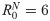
The dependence of R0 on the vaccine-induced sterilizing immunity, ϵs, vaccine-induced reduction in host infectivity, ϵi, vaccine-induced increase in recovery rate, ϵγ, and vaccine coverage, p.A. 3D surface plot corresponding to R0 = 1 in Eq (12), for a high average transmission potential (R0N=6) and full immunization coverage (p = 1). B. 2D contour plot showing the dependence of R0 on ϵi and ϵγ, for different values of ϵs and p = 1. C. 3D surface plot corresponding to R0 = 1 in Eq (12), for a high average transmission potential (R0N=6) and ϵi = 0.5. D. 2D contour plot showing the dependence of R0 on the effective vaccine coverage, p, and ϵγ, for different values of ϵs and ϵi = 0.5. The coloured continuous curves in 2D plots correspond to R0 = 1 in Eq (12) for a high average transmission potential (R0N=6) and dotted curves correspond to R0 = 1 for a low virulent PRRSv strain (R0N=2). Areas above these curves correspond to R0 < 1 where the infection cannot invade the herd. Here d = 0.001, μ = 0.0017. The transmission and recovery rates are values within the ranges given in Table 2, that satisfy R0N=6 and R0N=2 for the continuous and dotted curves, respectively.